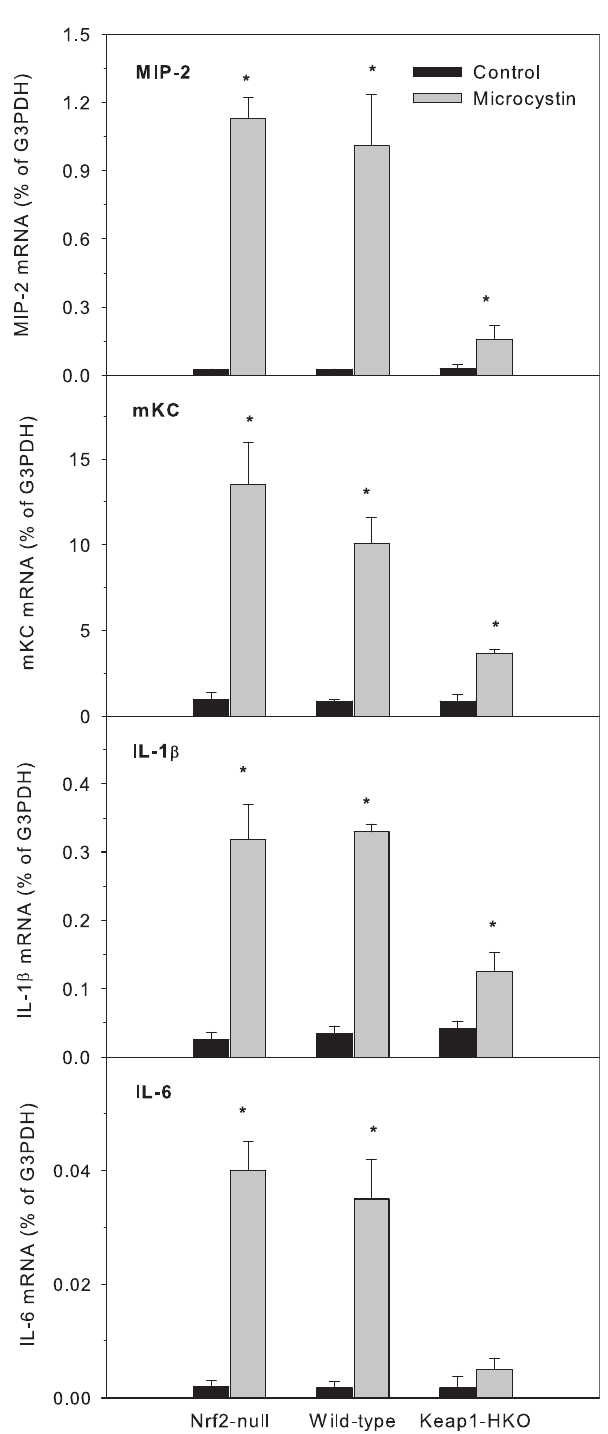
Figure 5. The mRNA levels of neutrophil-specific chemokine macrophage inflammatory protein 2 (MIP-2), mouse keratino- cyte-derived chemokine (mKC), inflammation genes interleu- kin-1 b (IL-1 b ) and IL-6 in Nrf2-null, wild-type and Keap1-HKO mice administered saline (10 ml/kg, i.p.) or microcystin (50 m g/ kg, i.p.). Livers were removed 8 h after microcystin and mRNA quantified by RT-PCR. Values are expressed as mean 6 S.E.M. (n=8). *Significantly different from the basal level of the same genotype (p # 0.05); # Significantly different from Nrf2-null mice treated with microcystin (p #